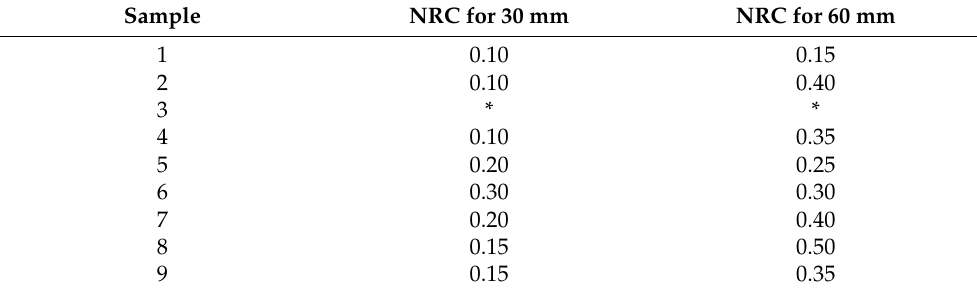
Table 5. Noise reduction coefficient (NRC) for the tested bark boards (* sample 3 is scored-out due to inconsistent results).